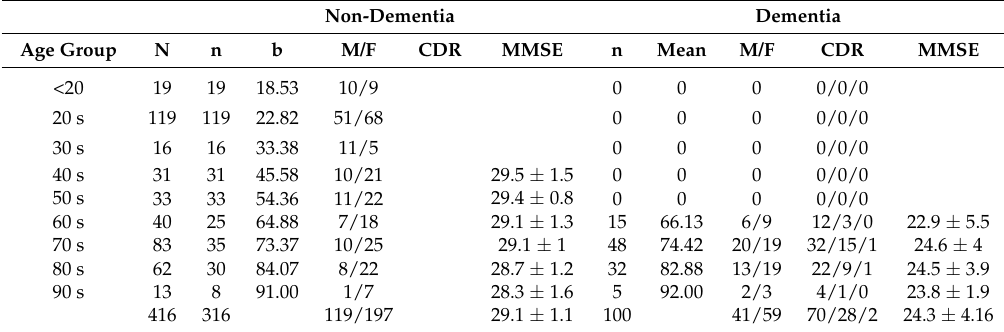
Table 1. Demographic characteristics of the population studied (OASIS-1 database). Clinical Dementia Rating scale (CDR) values are indicated as the number of patients diagnosed as very mild dementia/mild dementia/moderate dementia. Mini-Mental State Examination (MMSE) values are indicated as mean ± standard